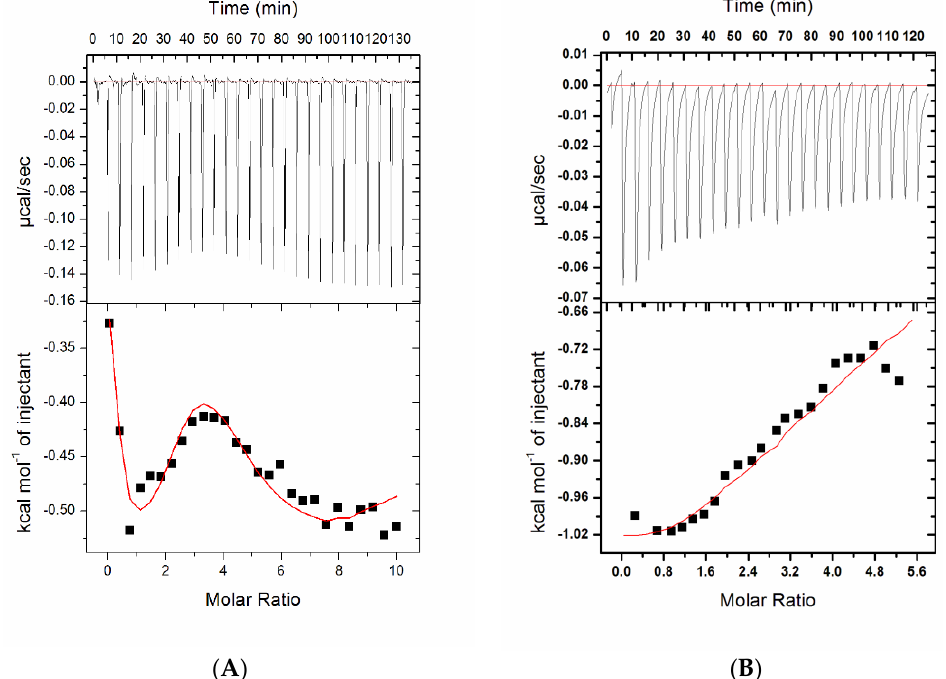
Figure 6. ITC experiment showing the titration of SphK1 with ( A ) Compound 1 and ( B ) Compound 7 . The upper panel depicts the raw data for heat produced against time for each titration of SphK1 with ligands. The bottom panel shows the binding isotherm formed by the integration of peak area and its normalization to yield a plot of molar enthalpy change against Compounds 1 / 7 and SphK1 ratio. The red color line represents the fitted curve.